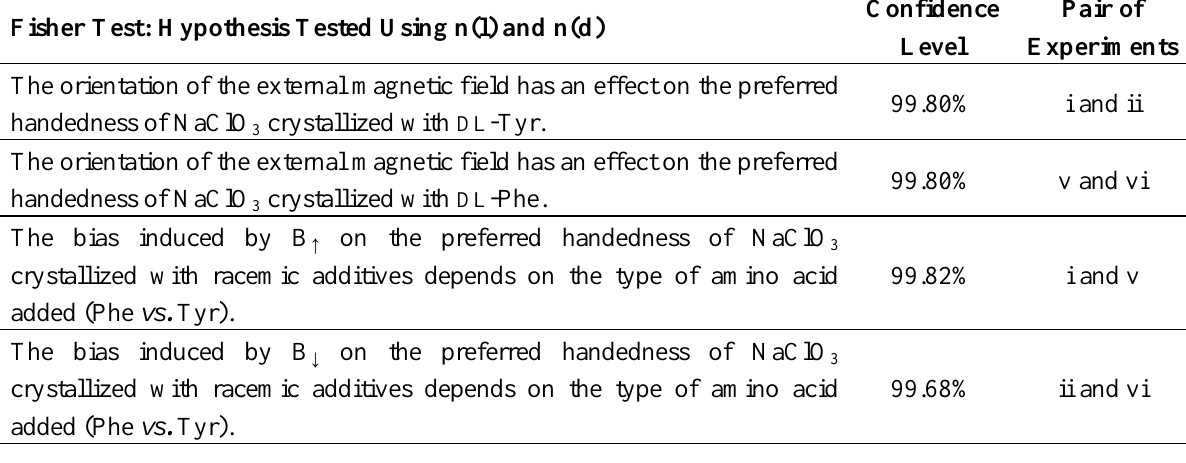
Table 5. By applying the Fisher test to pairs of experiments of Table 4 where only one condition is changed all hypotheses with confidence level above 95% are